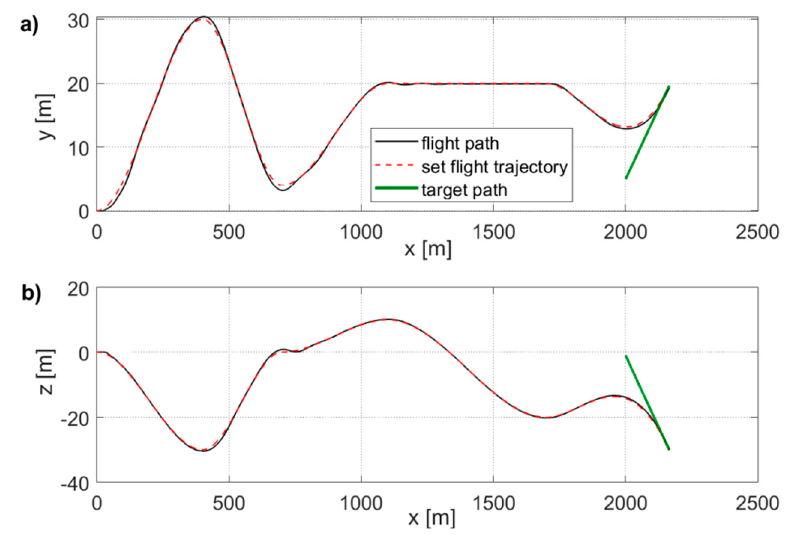
Figure 12. The performed trajectory in the 3D space.